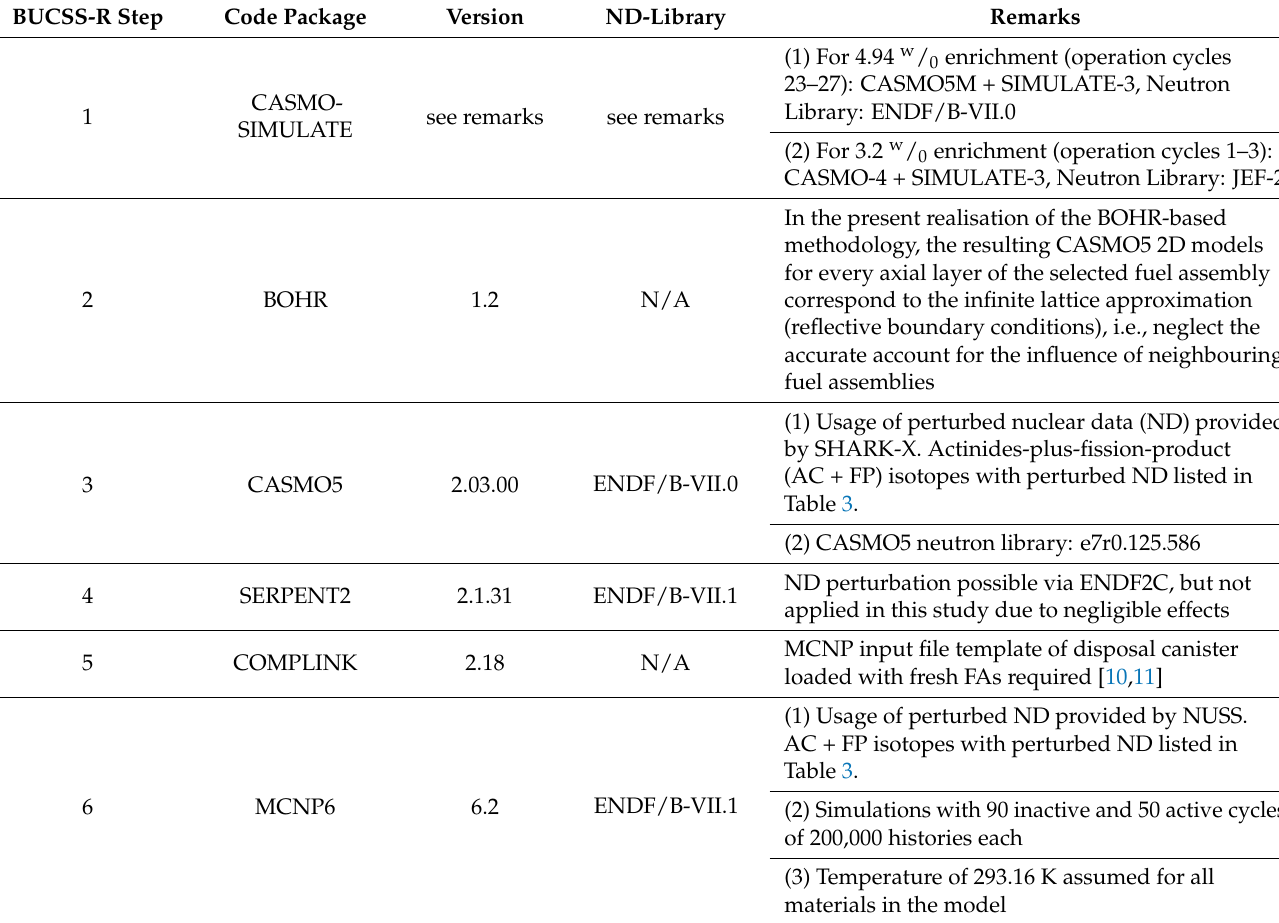
Table 2. Overview about materials, execution options and other information used in every step of the BUCSS-R scheme.